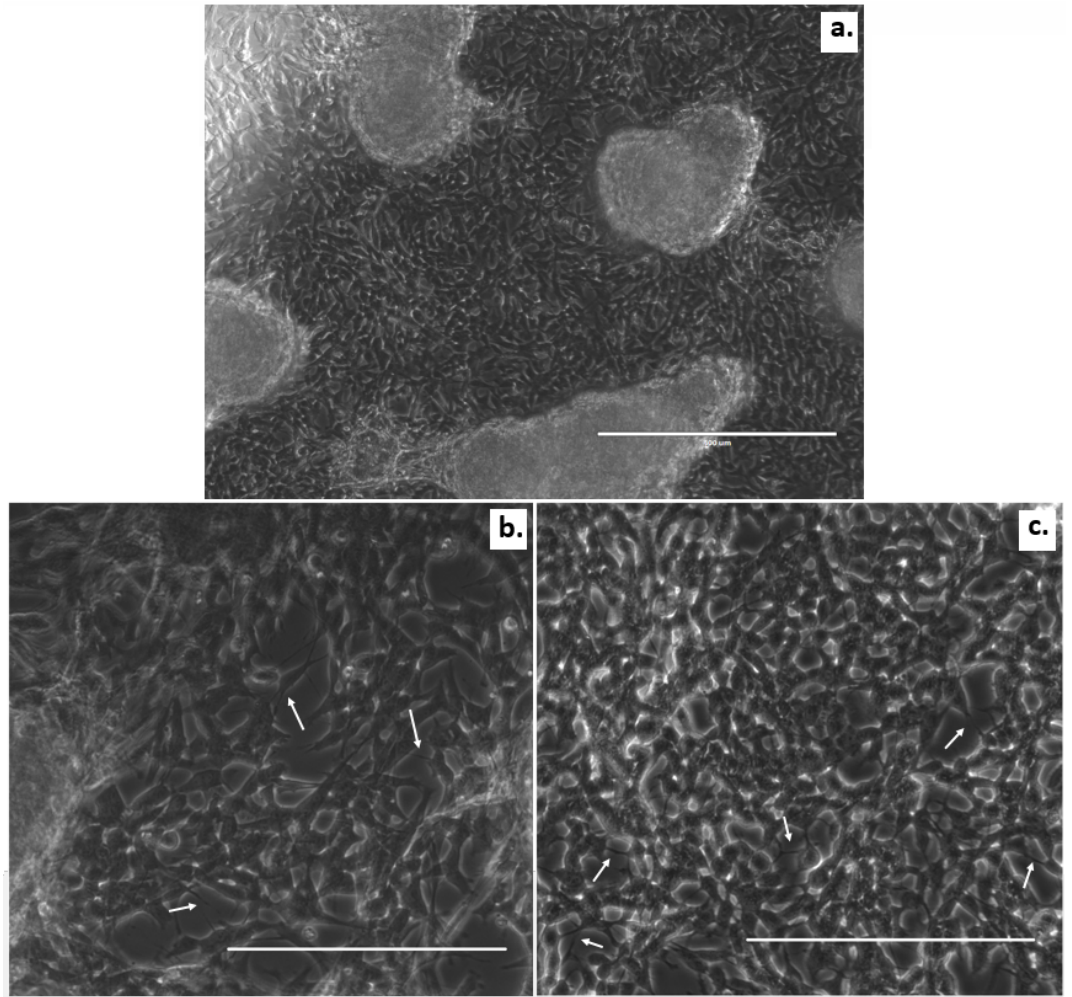
Figure 4. Morphology of the SH-SY5Y neuroblastoma cells in 3D culture. A larger field of view of the SH-SY5Y cells with GelMA on top on day 5 ( a ). The SH-SY5Y cells with GelMA on top imaged on day 1 ( b ) and day 5 ( c ). Images were taken using a EVOS FL microscope (Thermo Fisher Scientific, Eindhoven, The Netherlands) in the bright-field mode. White arrows indicate neuron-like phenotypes and neuronal outgrowths. The scale bars indicate 400 µm (a) and 200 µm ( b,c